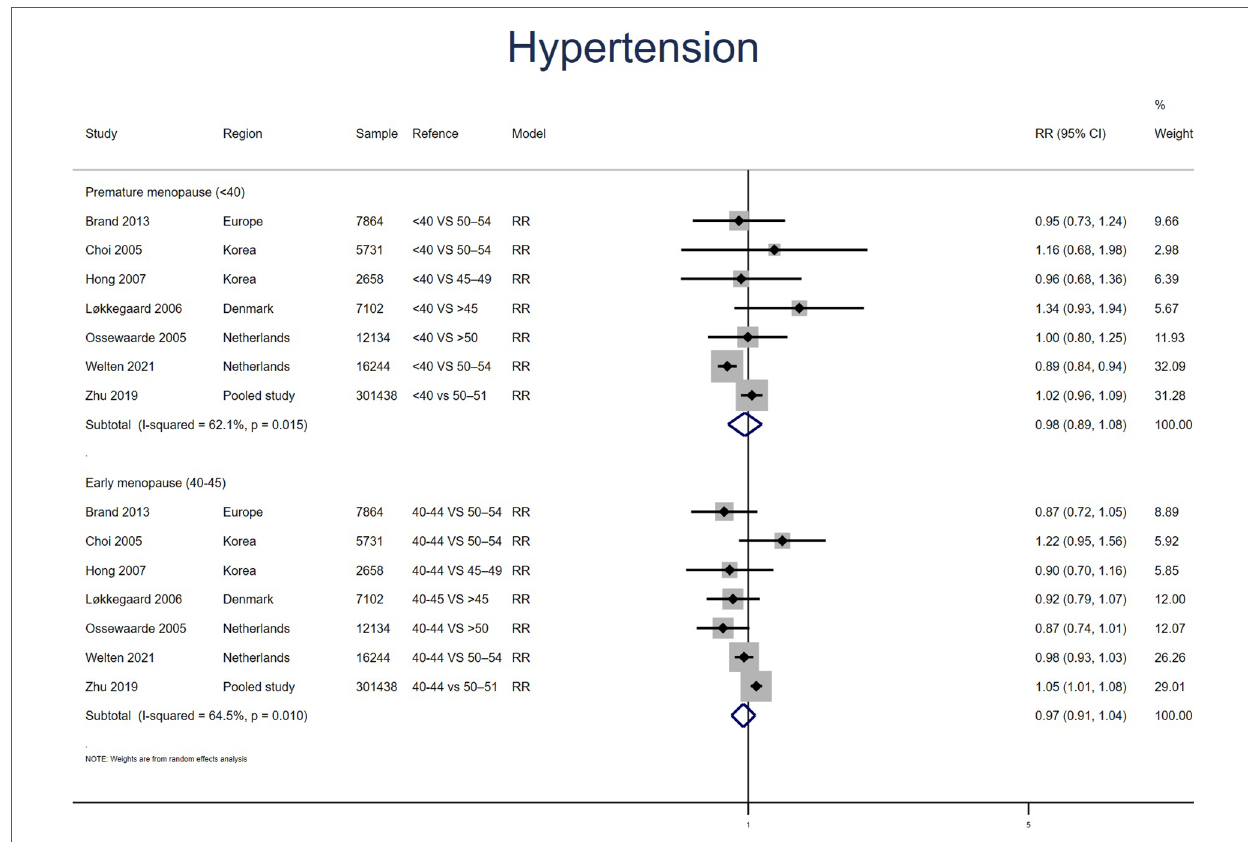
FIGURE 3 Forest plot presents the association between PM or EM and the risk of hypertension in cohort study.